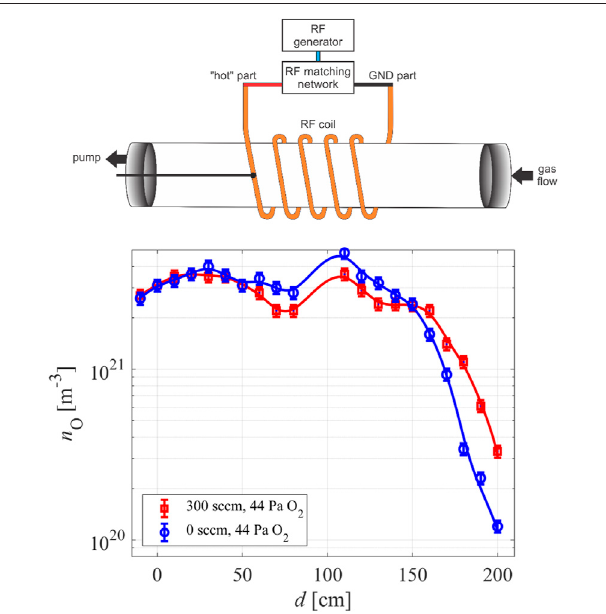
FIGURE 7 | The density of O-atoms versus probe position in the reactor of Figure 6 with a schematic of the reactor (not to